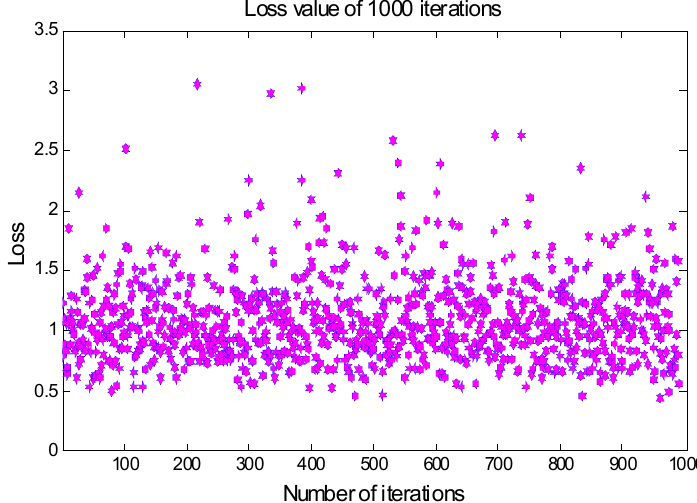
Figure 9. Loss value of 1000 iterations.